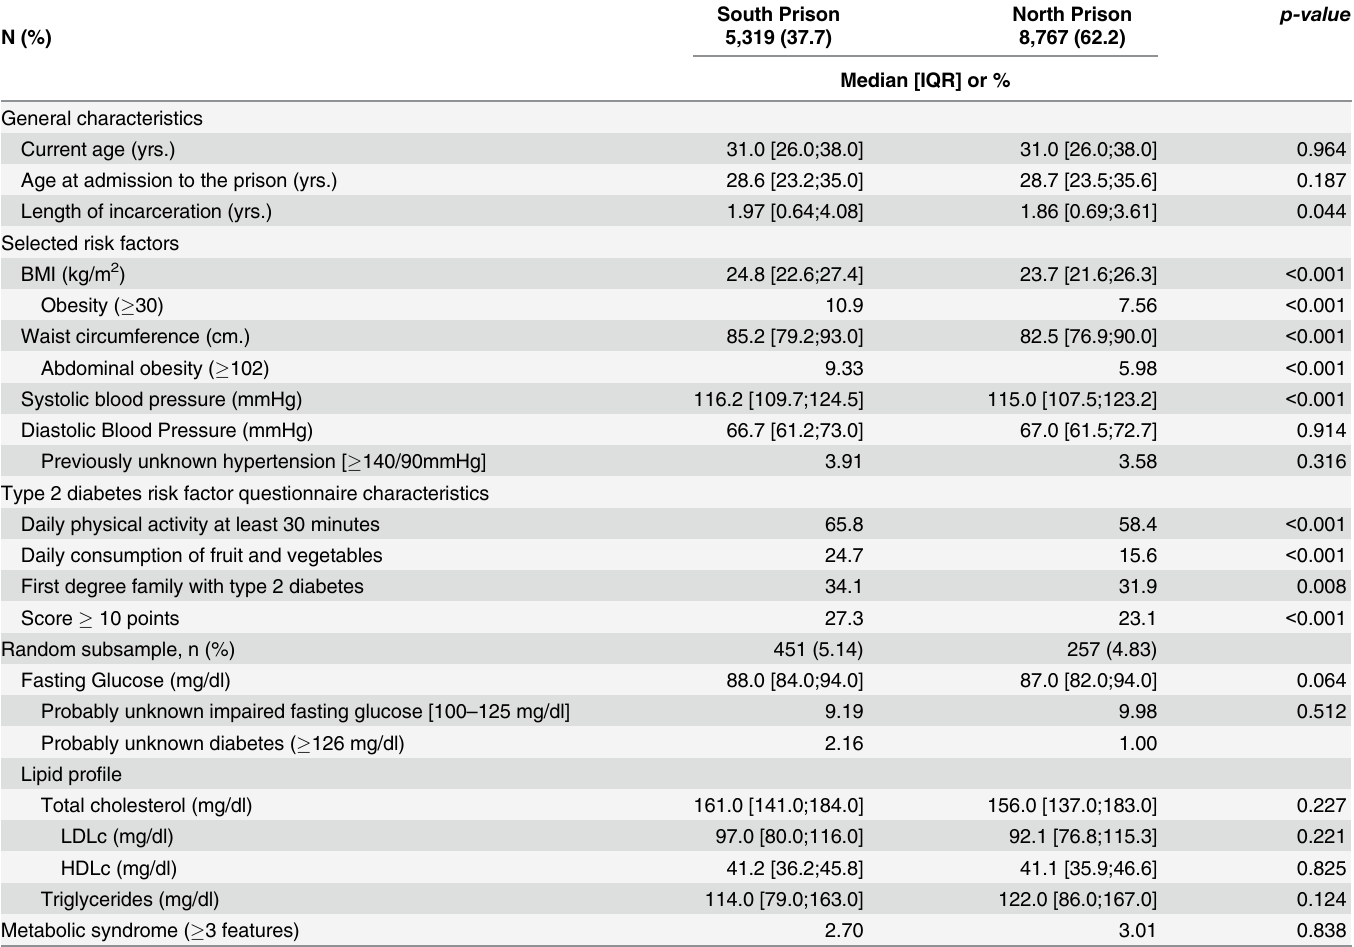
Table 1. Inmates ’ general characteristics, selected risk factors and type 2 diabetes risk factor questionnaire characteristics by prison